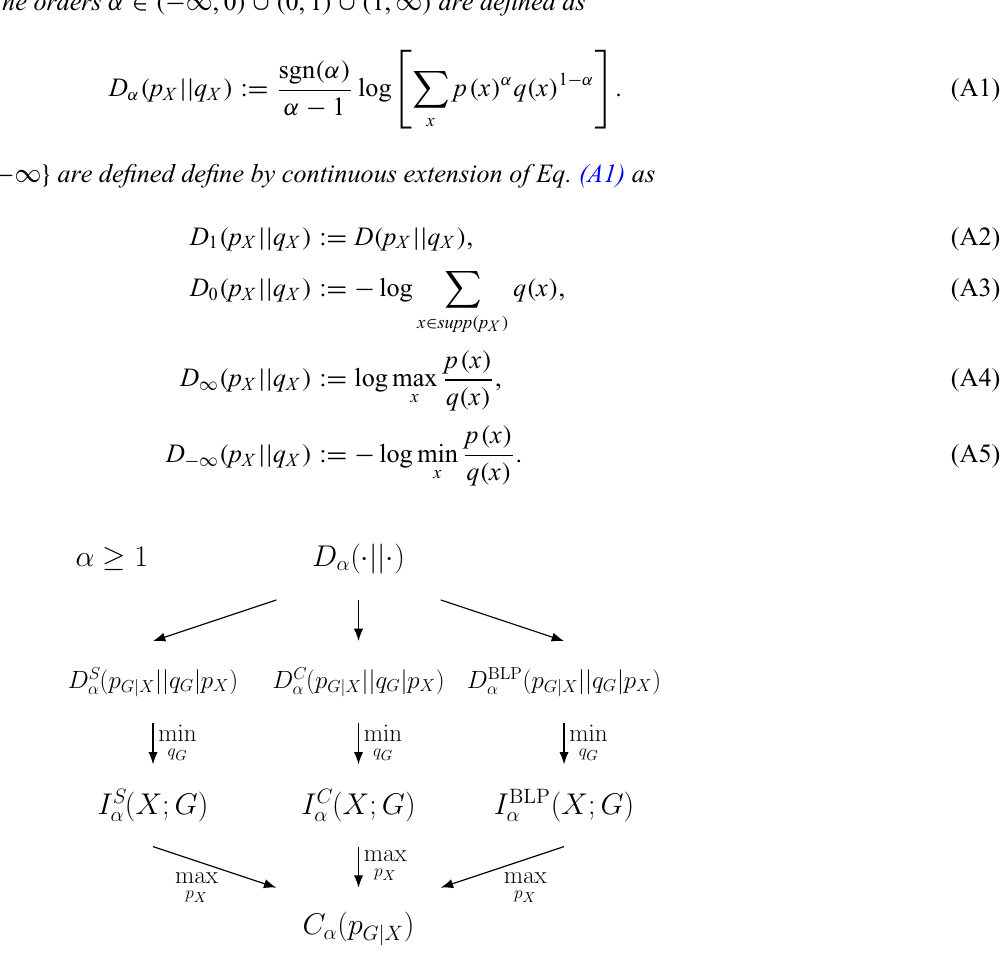
FIG. 5. Hierarchical relationship between the Rényi divergence D α ( ·||· ) , conditional Rényi divergences D V α ( ·|| · |· ) , mutual informa- tions I V α ( X ; G ) , and the Rényi channel capacity C α ( p G | X ) with α ≥ 1, and V ∈ { S , C , BLP } a label specifying the measures of Sibson [40], Csiszár [42], and Bleuler-Lapidoth-Pfister [38]. The mutual information associated to the BLP conditional Rényi divergence was independently derived by Lapidoth-Pfister [43] and Tomamichel-Hayashi [44]. In this work we address the capacities generated by Sibson and